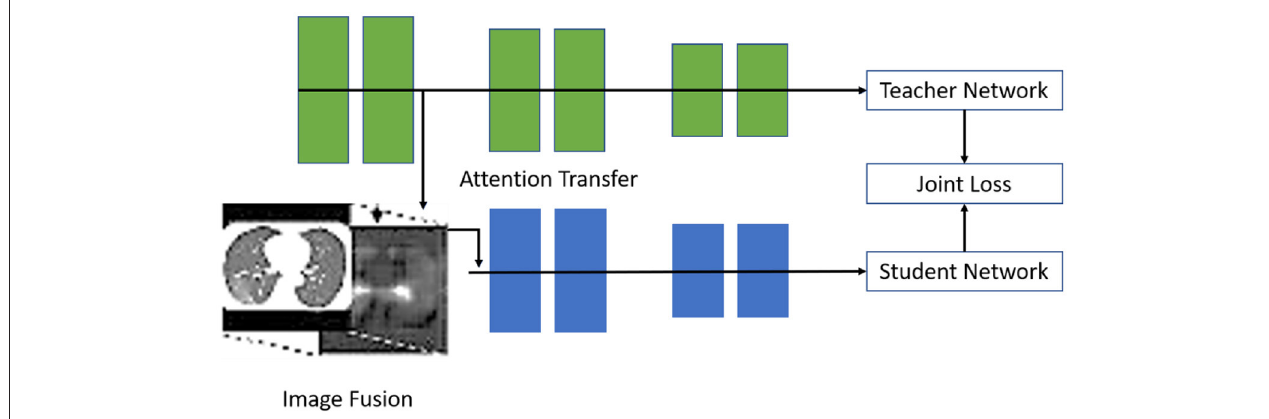
FIGURE 3 | The suggested architecture may be split into a teacher network and a student network (Shah et al.,